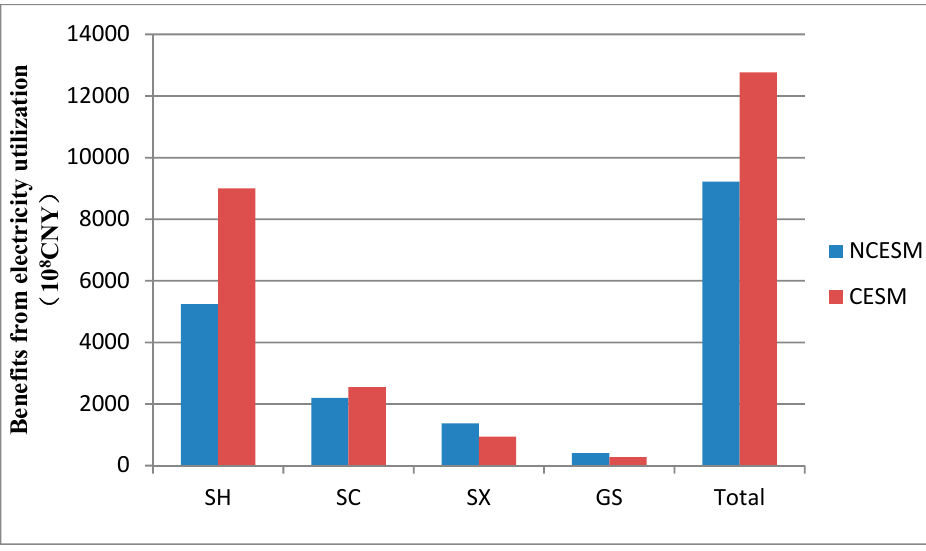
Figure 2. Comparison of benefits from electricity utilization under the two models.